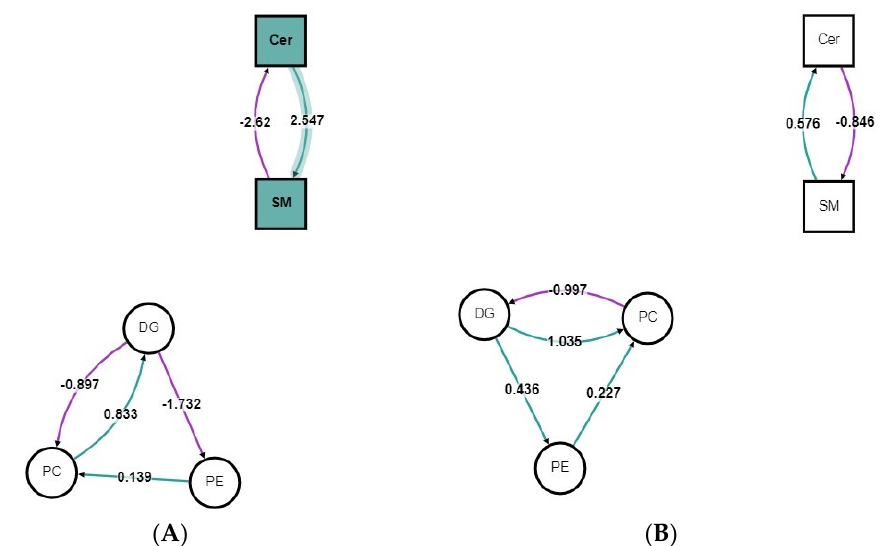
Figure 4. BioPAN lipid networks. Lipid network graphs exported from BioPAN for the HFHS diet vs. control ( A ) and the HFHS + GSM diet vs. HFHS diet ( B ) in OVX rats. Green nodes correspond to active lipids and green shaded arrows to active pathways. Reactions with a positive Z score have green arrows, while negative Z scores are coloured purple.